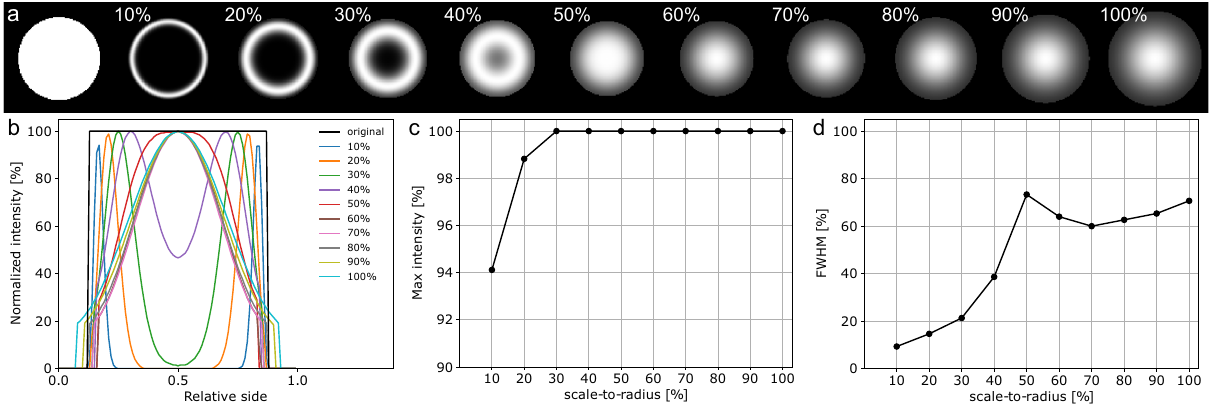
Figure 7. ( a ) Cross-sectional view of the Frangi’s vesselness probability of a simulated 3D fiber (left), obtained by adopting increasing scale-to-radius ratios; ( b ) 1D cross-sectional vesselness profiles, normalized with respect to the original intensity; ( c ) normalized maximum intensity; ( d ) normalized FWHM. The optimal scale corresponds to a scale-to-radius ratio of